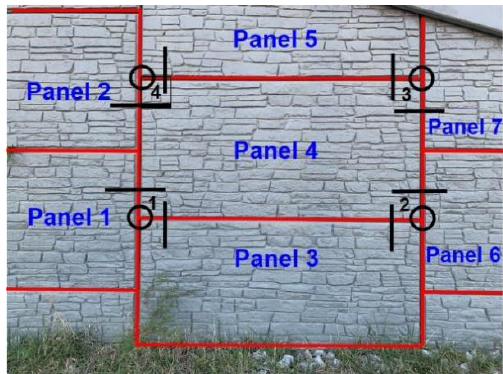
Figure 18. Illustration of the relationship between 𝐿𝐹 𝑐𝑠 and 𝑃 𝑐𝑠 for deriving the panel position and orientation serviceability measures.